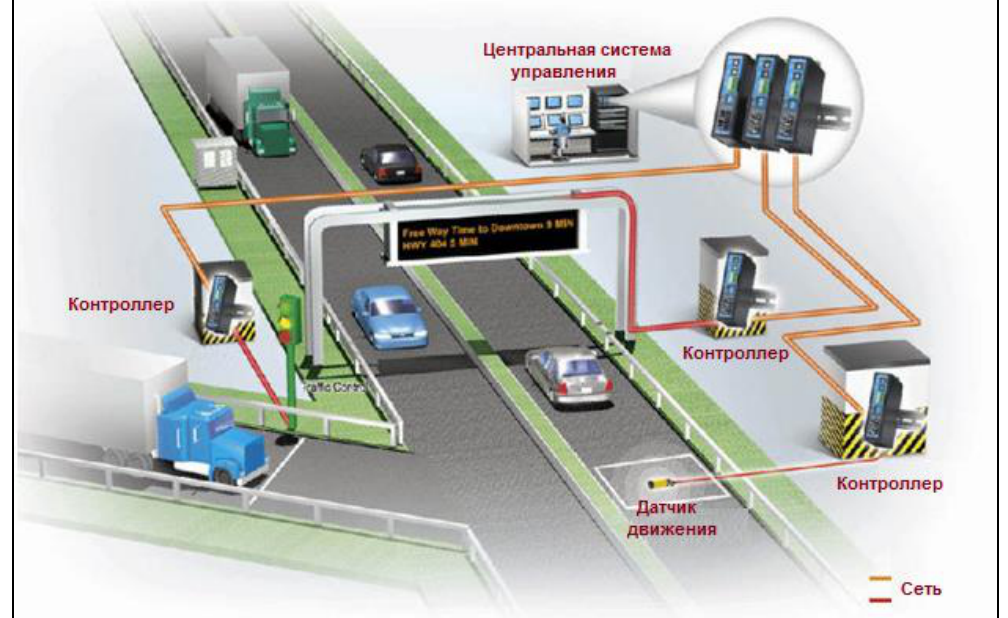
Figure 12. The Intelligent Traffic Light